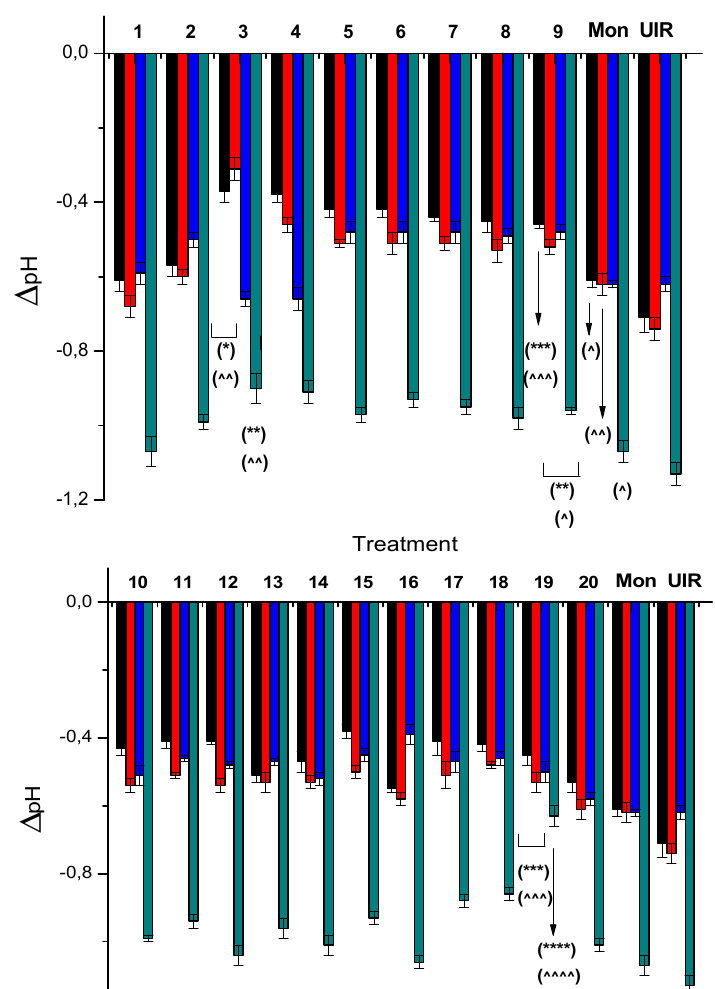
Figure 4. The variation in rumen pH, expressed as Δ pH = pH initial − pH studied time at each checkpoint, with time of the different treatments for the studied compounds at 0.82 ppm (black: 4 h; red: 6 h; blue: 12 h; green: 96 h). (*) p = 0.04 with respect to Mon; (**) p = 0.03 with respect to Mon; (***) p = 0.008 with respect to Mon; (****) p = 0.001 with respect to Mon; (^) p = 0.04 with respect to UIR; (^^) p = 0.008 with respect to UIR; (^^^) p = 0.004 with respect to UIR; (^^^^) p = 0.001 with respect to UIR.